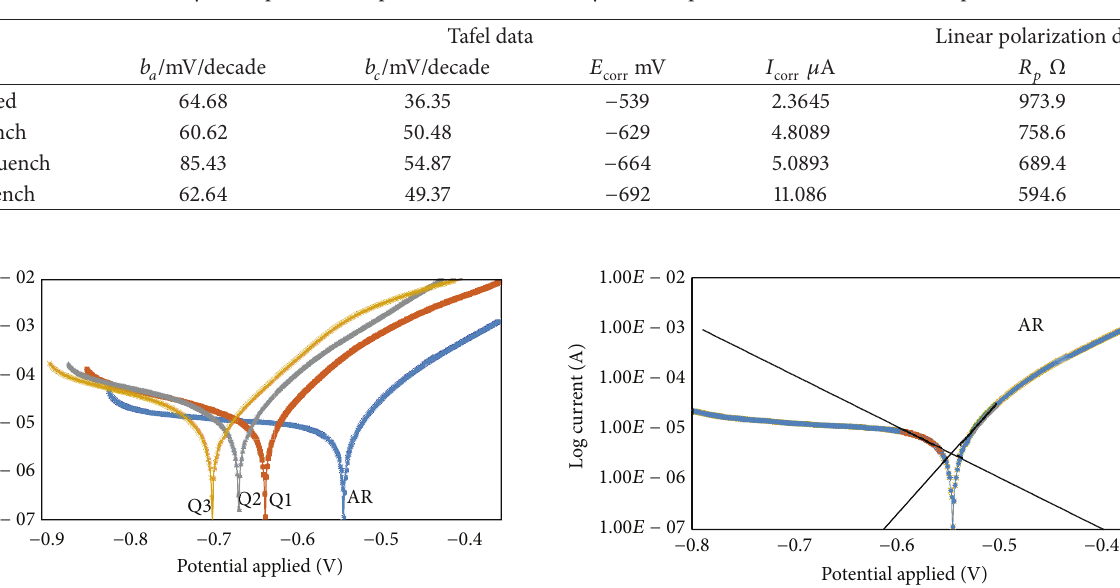
Figure 1: The microstructure of (a) as received, (b) first quench, (c) second quench, and (d) third quenched E-34; all magnifications were 4 × 40x. Table 4: Potentiodynamic polarization parameters of microalloy steel samples in 3.5% NaCl at room temperature.